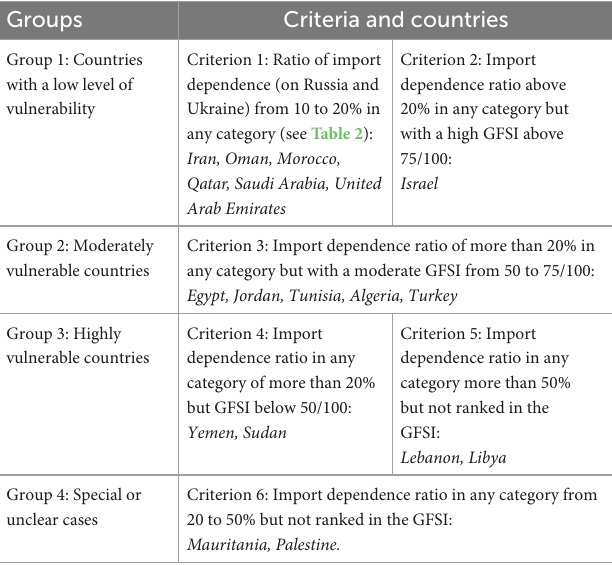
TABLE 4 Categorization of Middle Eastern countries in terms of vulnerability to food supply shocks from Russia and Ukraine.